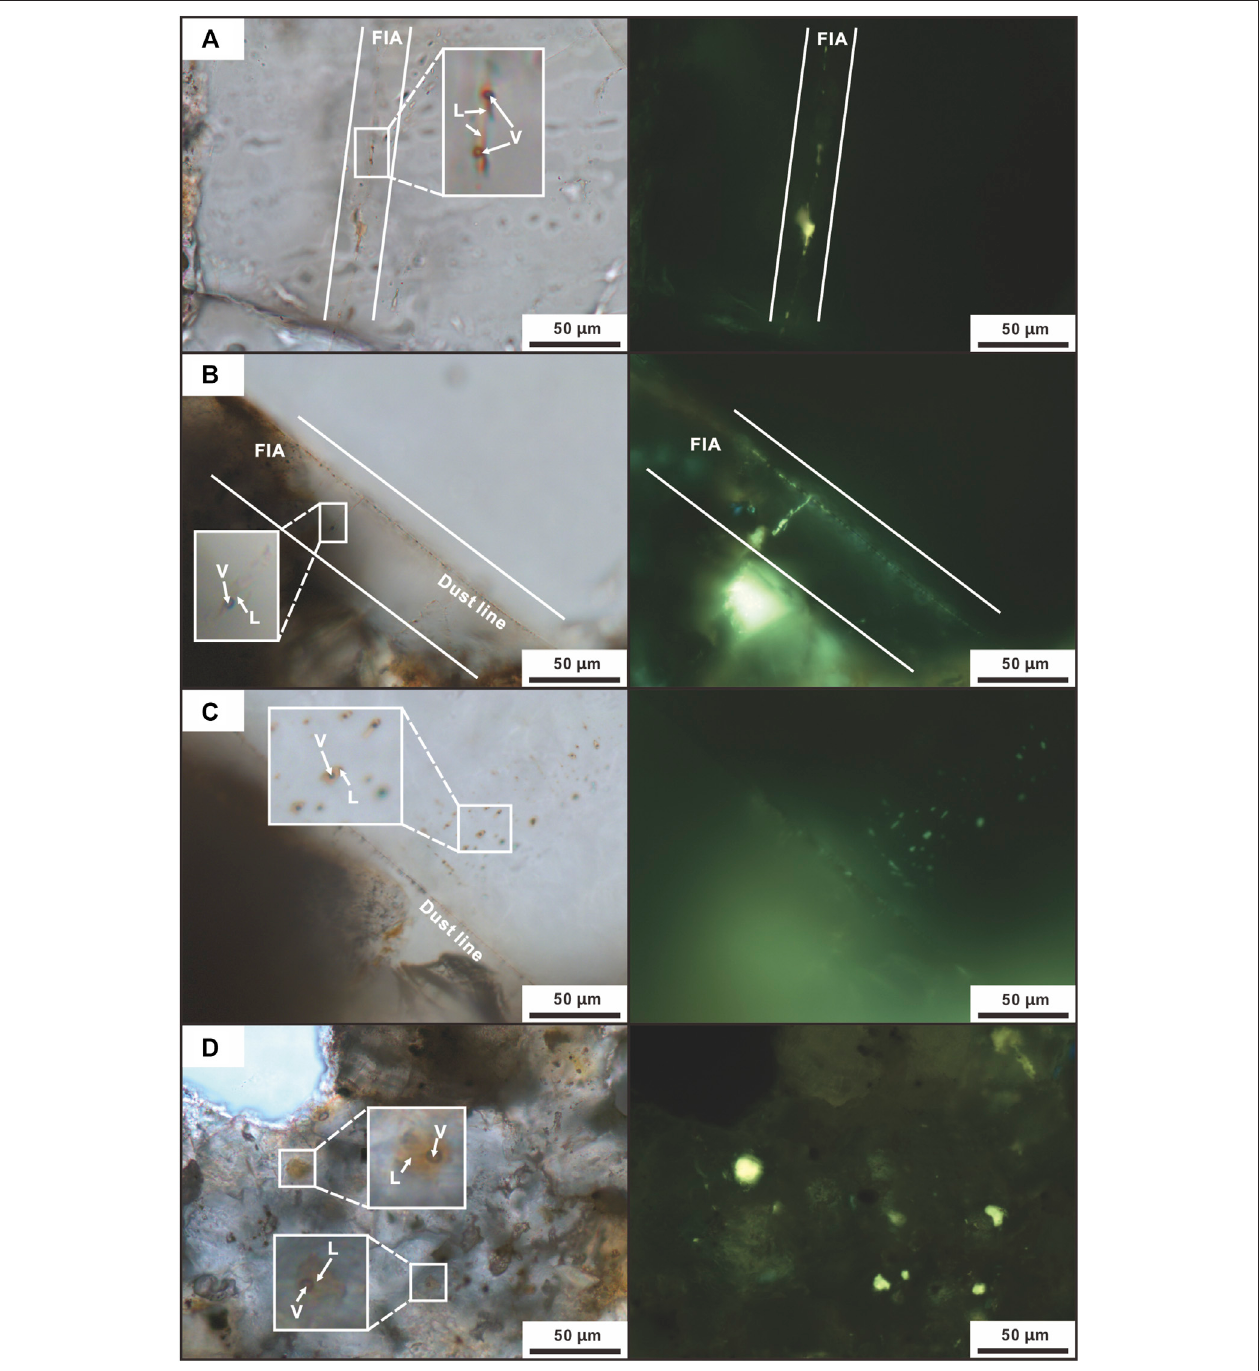
FIGURE 4 | Petrographic features of fl uid inclusion assemblages (FIAs) within quartz and carbonate in sandstone reservoirs in the Dongying Depression. (A) FIA occurredashealedmicrofracturewithinquartz,details(zoom)oftheareashownintheyellowboxin Figure3A . (B – C) Hydrocarboninclusionswithintheovergrowthand healed microfracture within the quartz particle show the same fl uorescence color, details of the areas shown in the yellow boxes in Figure 3B . (D) Two-phase, oil + gas hydrocarbon inclusions within Fe-calcite, details of the area shown in the yellow box in Figure 3C . V, vapor; L, liquid.